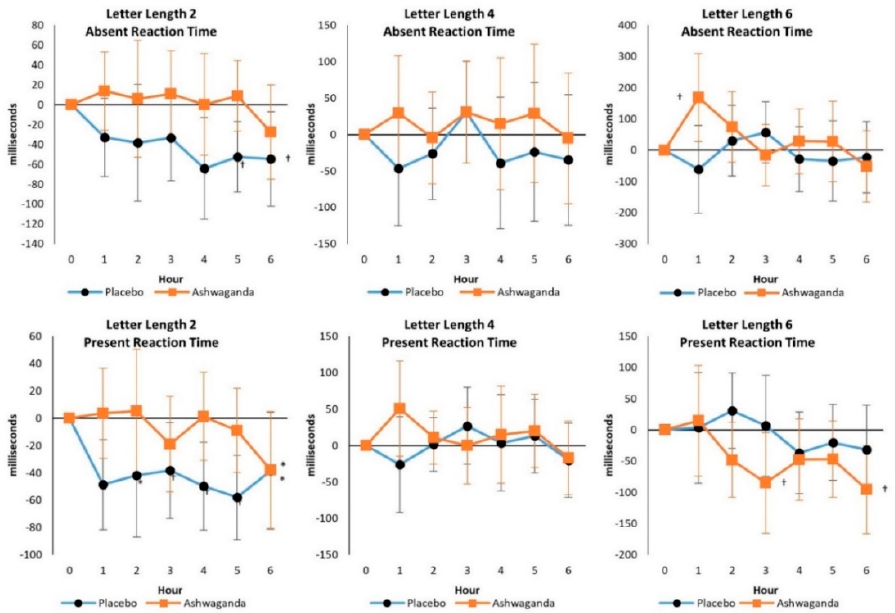
Figure 5. Sternberg Task Test responses. Data are mean differences from baseline with 95% confidence intervals. † indicates p < 0.05 difference from baseline values. * indicates p > 0.05 to p < 0.10 difference between treatments.